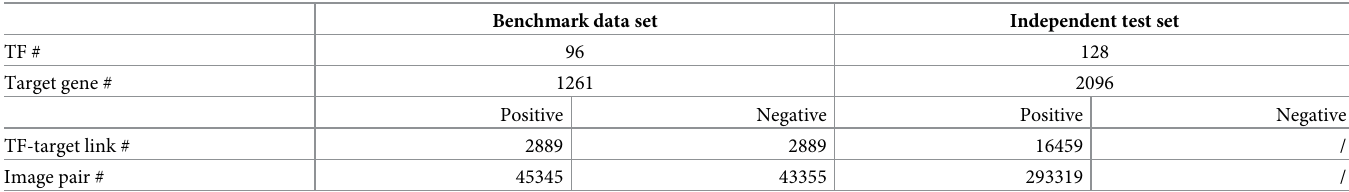
Table 1. Statistics of the data